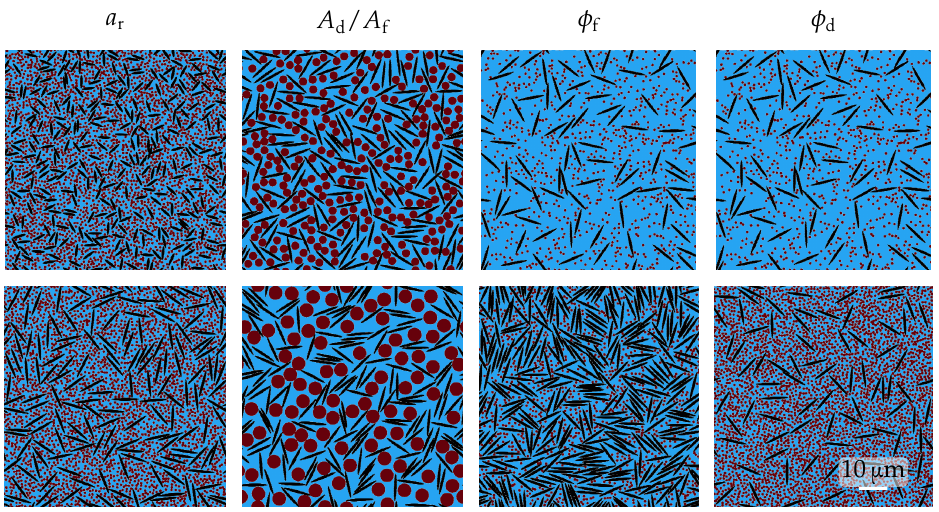
Figure 3. Micro-structures examples where in each column we show one variation of the quantity being denoted on top of the column.